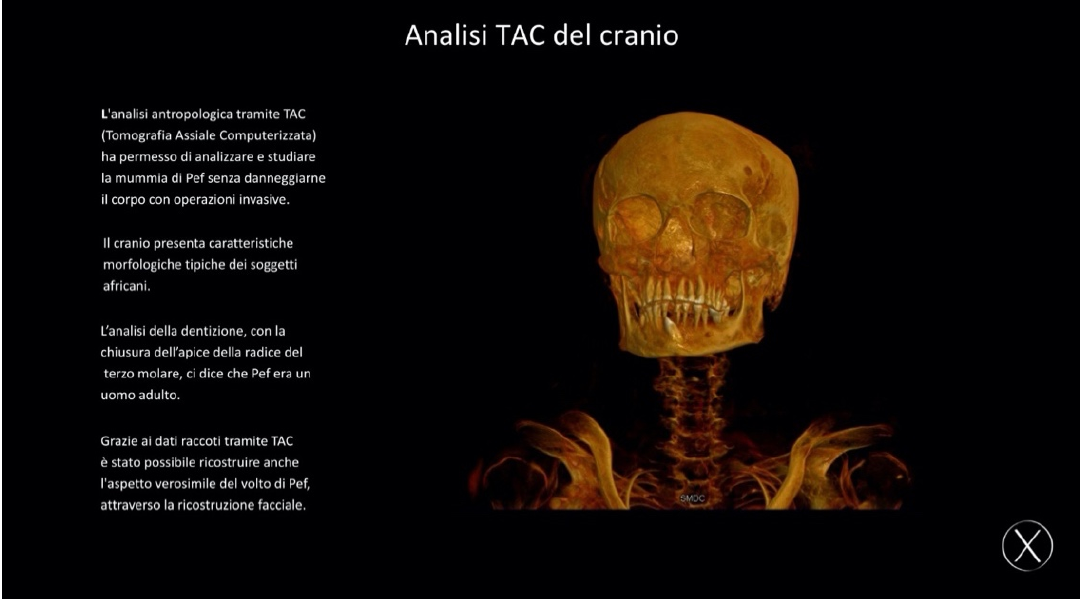
Figure 9. Images of the digital app interface at navigation Level IV, showing an item’s in-depth contents: CT scan video of a mummy’s head with textual explanation of the information that can be drawn from medical analyses, as for example the evident impacted tooth.